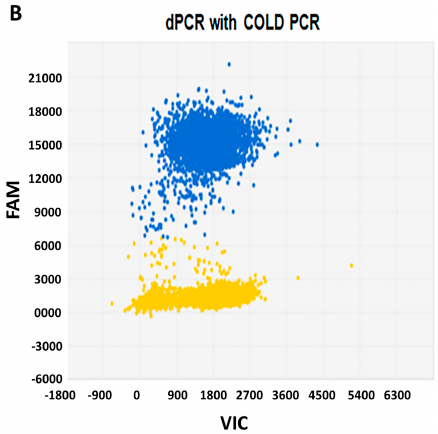
Figure 1. Detection of BRAFV600E by microfluidic digital PCR alone or in combination with COLD-PCR. Each panel represents a single experiment whereby DNA from BCPAP cells was segregated into individual wells and assessed for the presence of the mutant alleles using two different fluorophores (FAM and VIC). The signals from the FAM (blue) and VIC (red) dyes are plotted on the Y axis and the X axis, respectively. The yellow cluster represents the unamplified wells (negative calls). ( A ) Two-dimensional plots of microfluidic digital PCR reads out of 1 ng DNA extracted from BCPAP cells. Blue cluster represents the wells that were positive for the BRAFV600E mutation. ( B ) Results of dPCR analysis after the enrichment of BRAFV600E by COLD-PCR demonstrating 100-fold increase in mutant alleles (blue cluster). dPCR, digital Polymerase chain reaction;